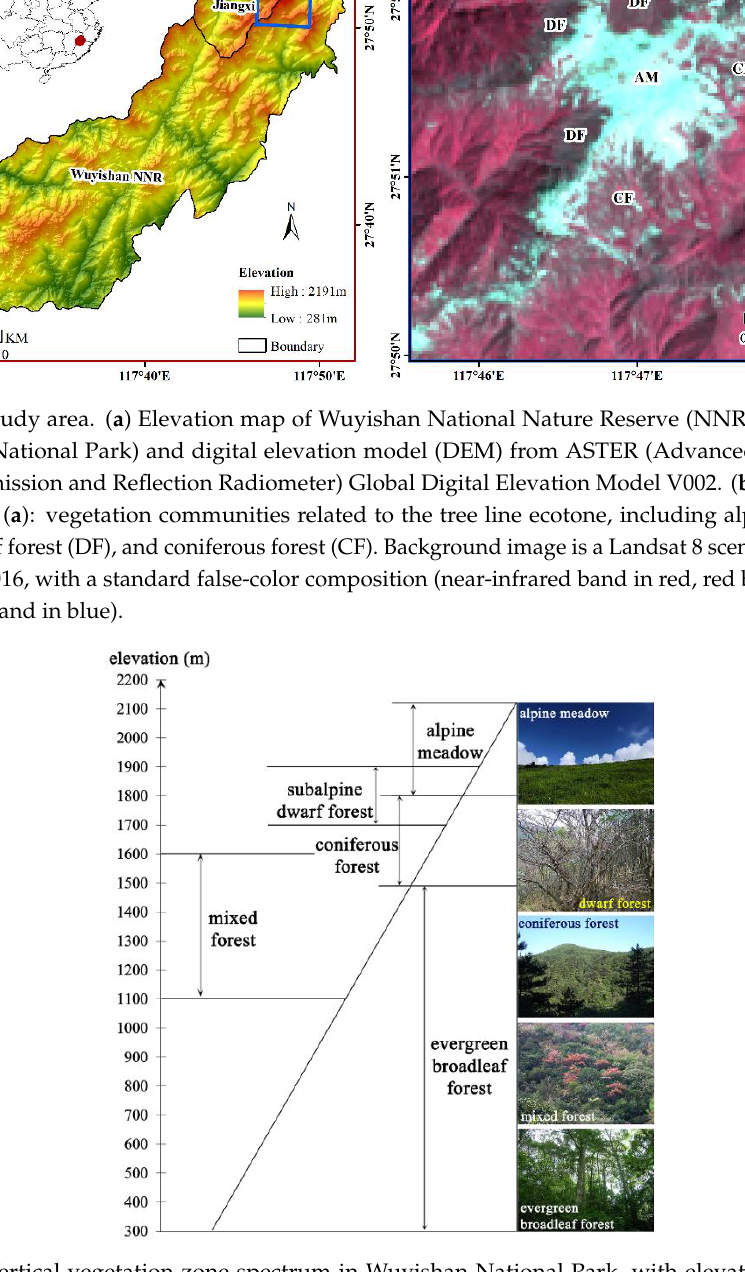
Figure 3. Vertical vegetation zone spectrum in Wuyishan National Park, with elevation ranges as follows. Alpine meadow: about 1800 – 2158 m; dwarf forest: about 1700 – 1900 m; coniferous forest: 1500 – 1800 m; mixed forest: 1100 – 1600 m; and broadleaf evergreen forest: 300 – 1500 m [88,89].